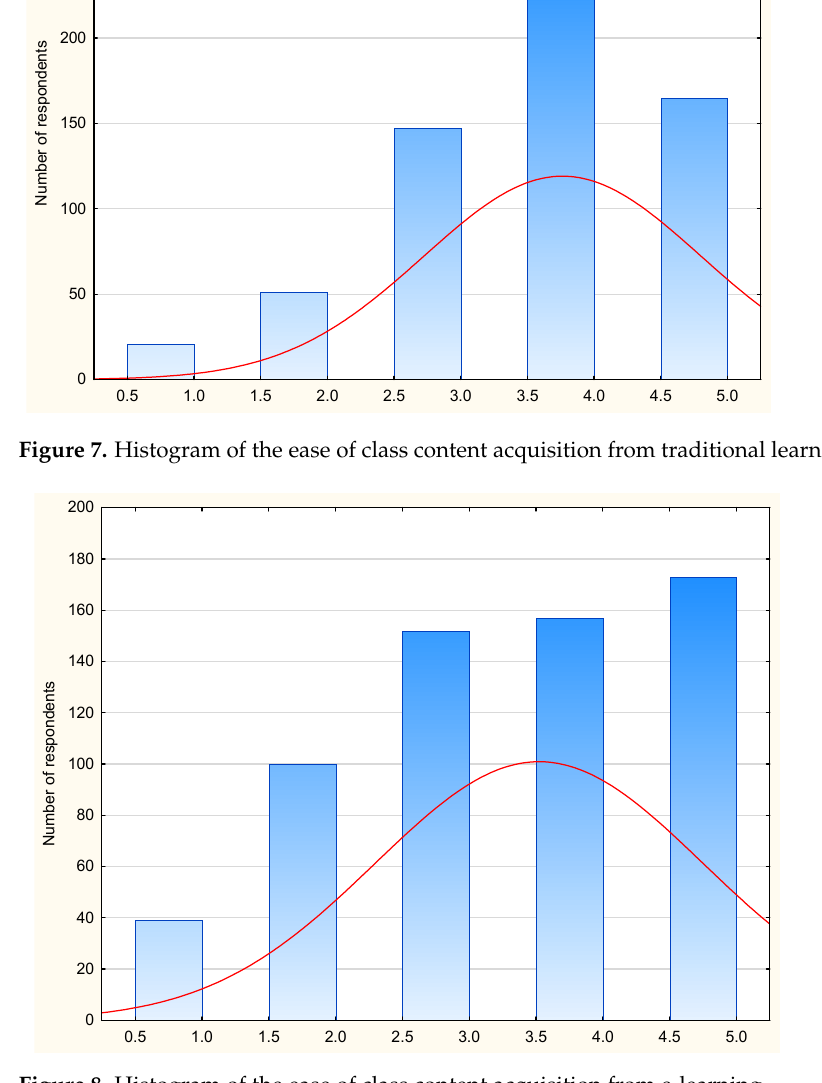
Figure 8. Histogram of the ease of class content acquisition from e-learning.